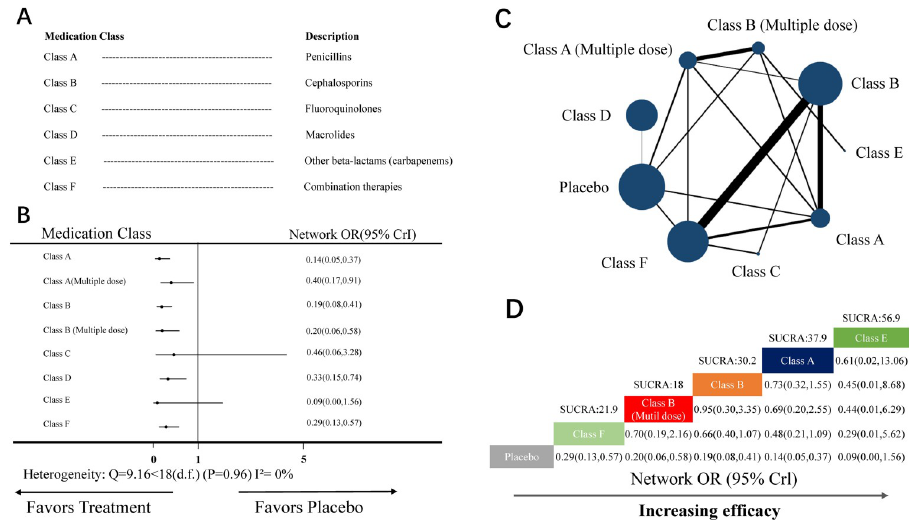
Fig 5. NMA for wound infection. (A) List of the included medication classes. (B) Forest plot of the NMA comparing each intervention against placebo. (C) Each node (blue circles) represents a unique medication class and dosage, and the size of each node represents the number of included women for the intervention. The connecting line indicates the number of direct comparisons between both nodes. The width of each line represents the number of direct comparisons between interventions. (D) Schematic detailing the most efficacious antibiotic class and dosage in NMA for wound infection compared with placebo for surface under the cumulative ranking curve analysis (SUCRA). NMA, network meta-analysis; OR, odds ratio; CrI, credibility